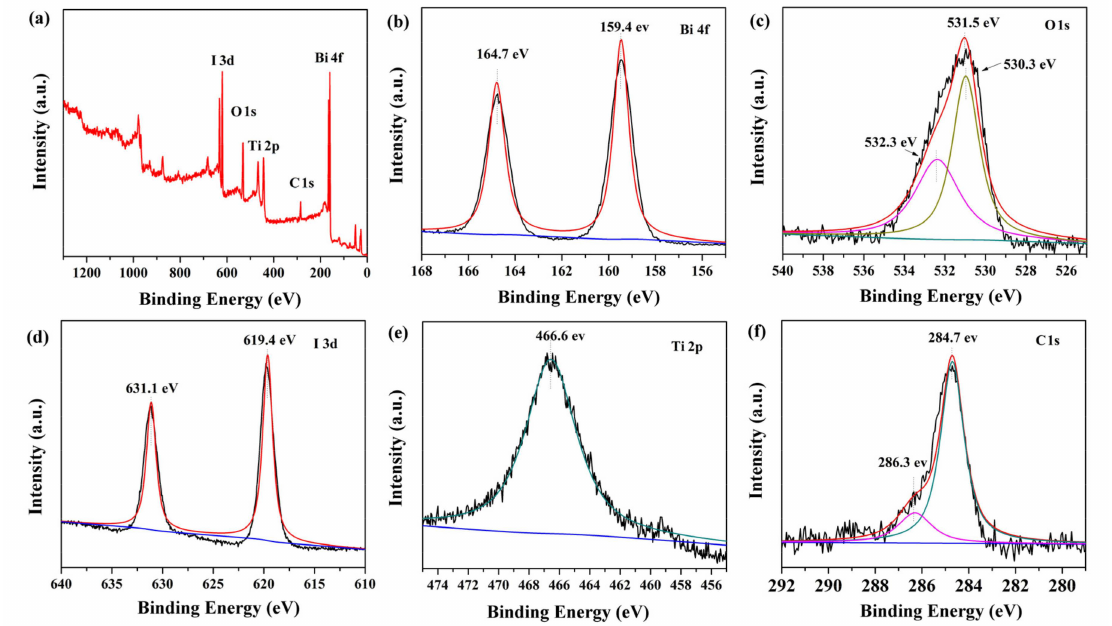
Figure 2. The XPS spectra of BiOI/NH 2 -MIL-125(Ti) (BNMT)-9 sample: ( a ) survey scan, ( b ) Bi 4f spectra, ( c ) O 1s spectra, ( d ) I 3d spectra, ( e ) Ti 2p spectra, and ( f ) C 1s